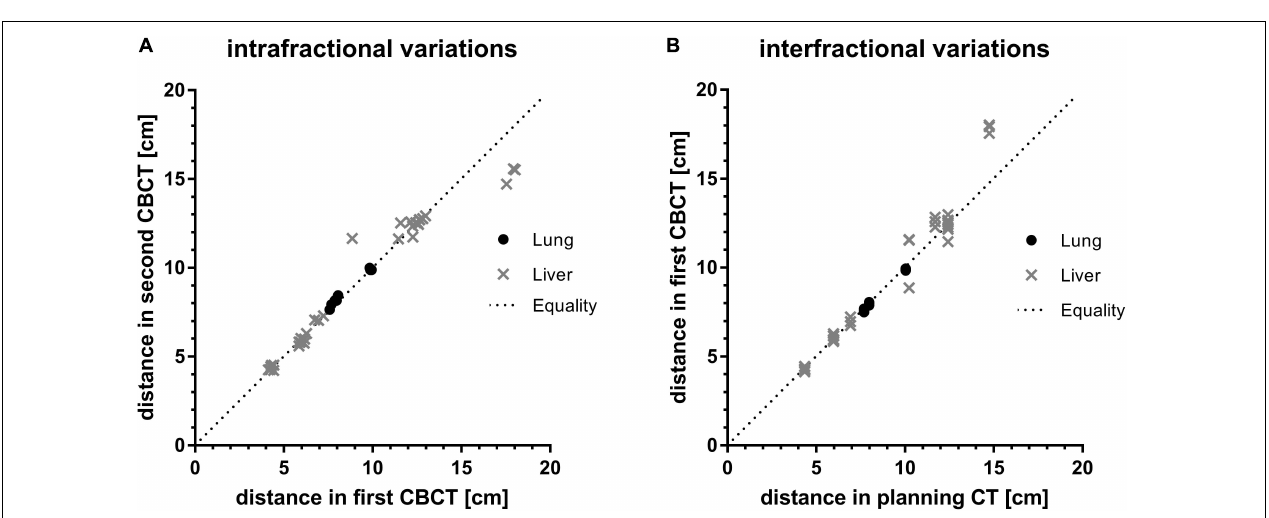
FIGURE 2 | Box plots with boxes extending from 25th to 75th percentiles. Whiskers are drawn down to 5th and up to 95th percentiles, respectively. (A) Couch shifts are shown in left (+) to right (–), cranial (+) to caudal (–) and anterior (+) to posterior (–) directions along the x -, y -, and z -axis, respectively. Values were grouped by target location and derived from first CBCTs for position verification after alignment of current DIBH surface to that of the reference surface. (B) Length of correction vectors of first CBCTs for image-guidance in DIBH and grouped by target location. Statistical difference was calculated by Welch’s t -test.